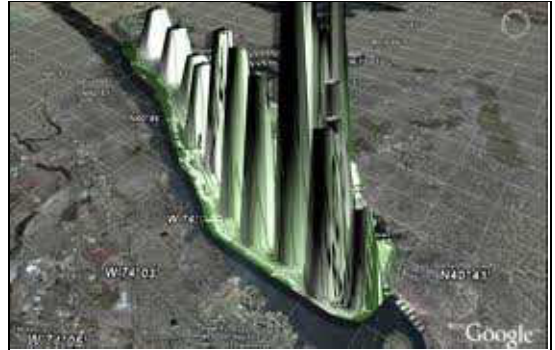
Fig. 6; Market value in New York,